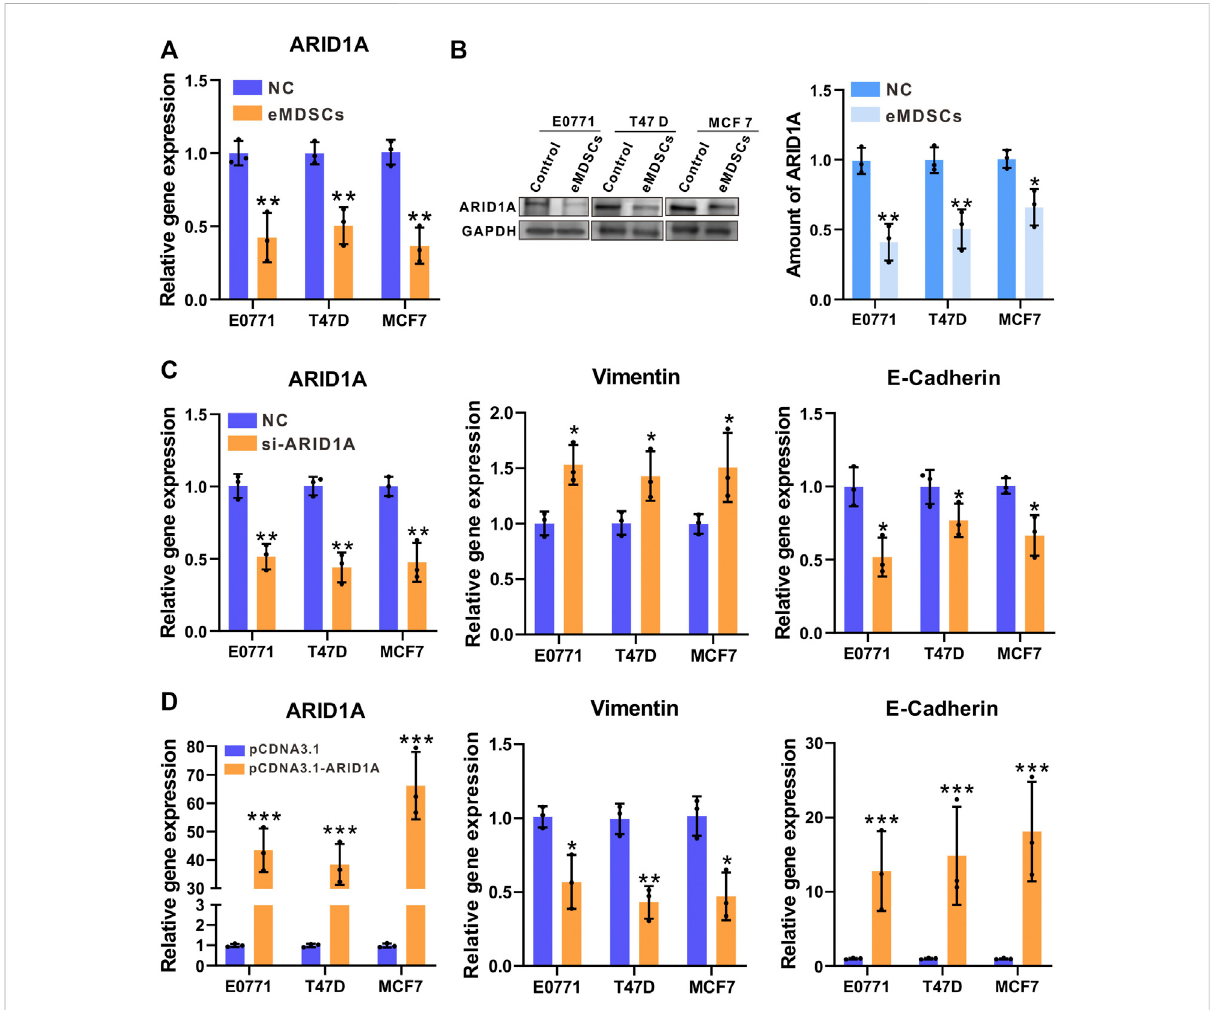
FIGURE 5 eMDSCs accelerate epithelial-mesenchymal transition in luminal A breast cancer cells by downregulating ARID1A (A,B) The mRNA and protein levelofARID1AweredeterminedbyRT-PCRandimmunoblottinginEO771,T47DandMCF7cellsaftercoculturedwitheMDSCs. (C) QuantitativeRT- PCR showing expression changes of ARID1A and EMT-related genes in EO771, T47D and MCF7 cells upon ARID1A knocked-down with the transfection of siRNA or vehicle. (D) Quantitative RT-PCR showing expression changes of ARID1A and EMT-related genes in EO771, T47D, and MCF7 cells cocultured with eMDSCs upon ARID1A overexpression plasmids or vehicle. * p < 0.05, ** p < 0.01, *** p <